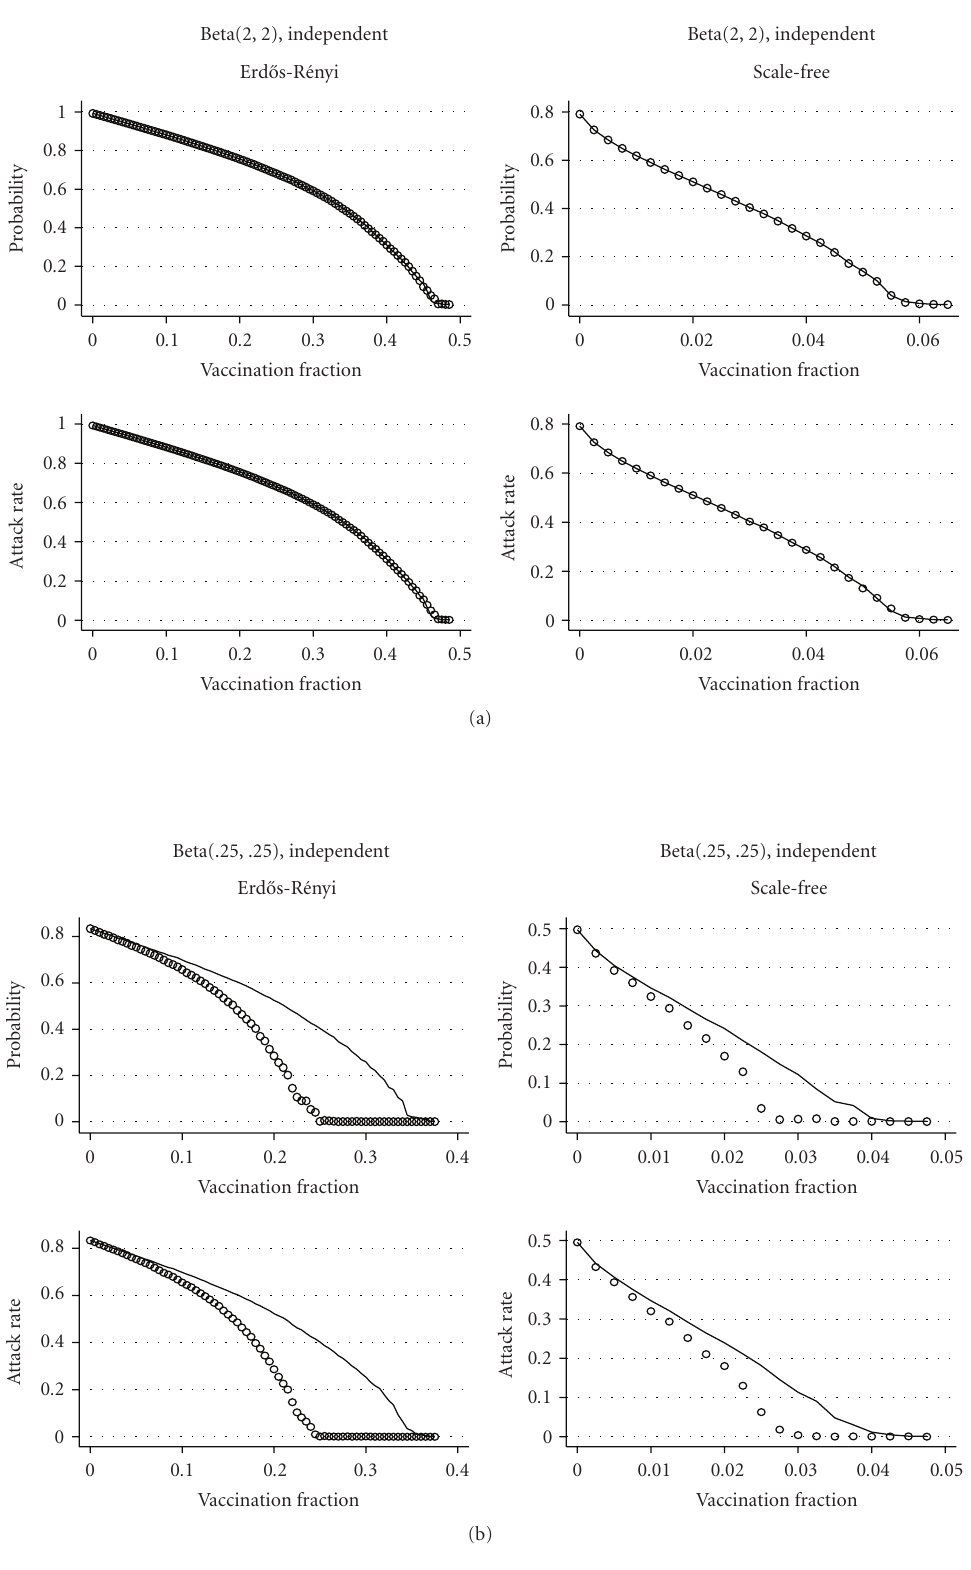
Figure 7: Comparison of targeting by contact network degree (lines) and targeting the GSCC (circles) in the network-based model from Section 4.2 with independent susceptibility and infectiousness. When infectiousness and susceptibility have beta(2, 2) distributions, the two strategies produce nearly identical results. When they have beta(.25, .25) distributions, targeting the GSCC is more e ff ective in reducing both the probability and attack rate of major epidemics on both Erd˝os-R´enyi and scale-free